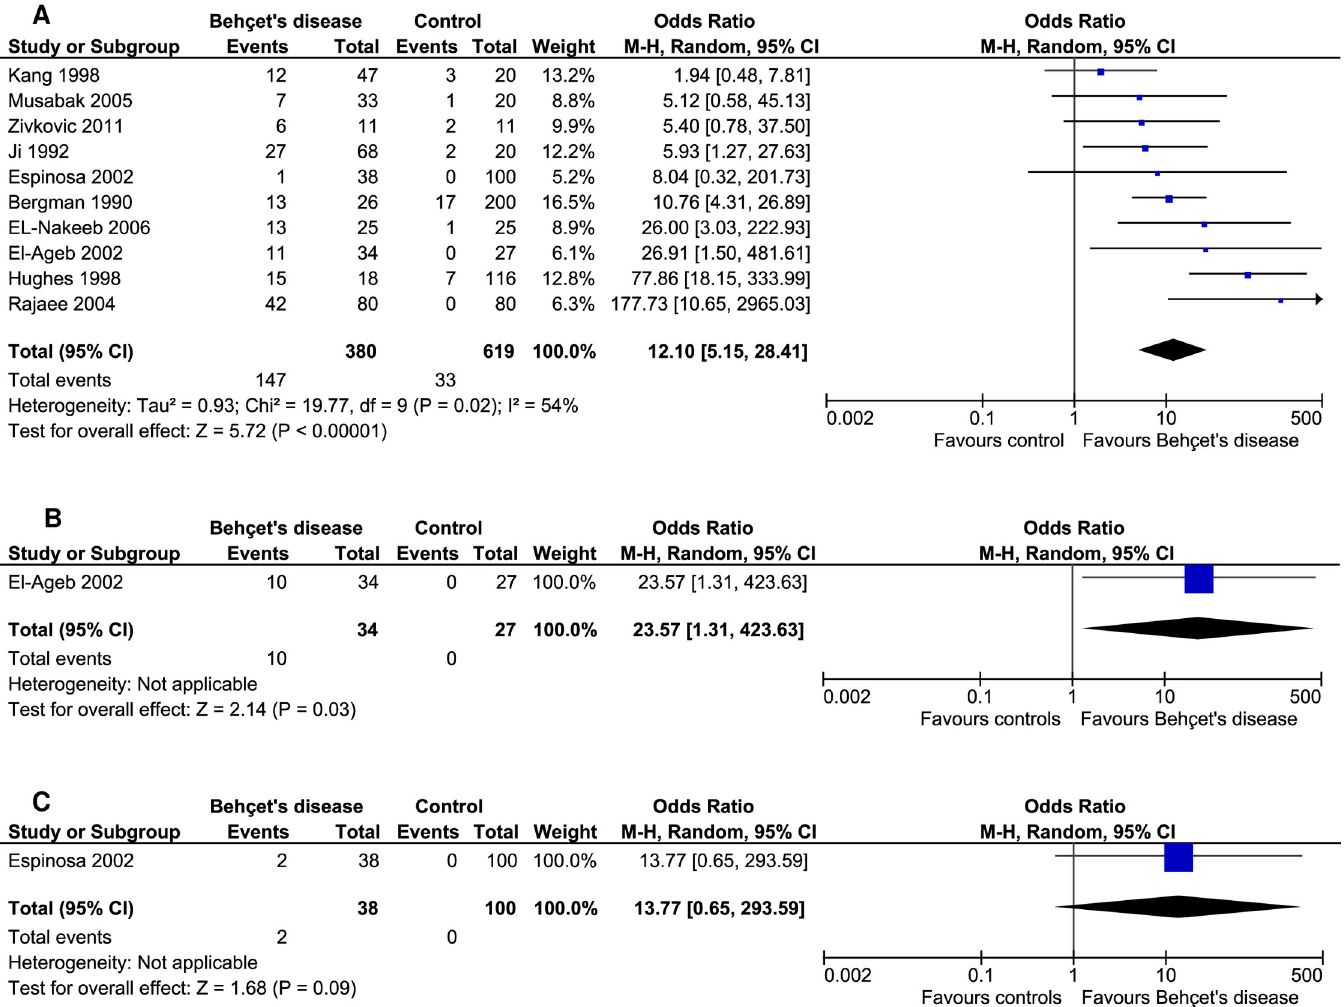
Fig 2. Forest plots showing the prevalence of aCL (A), anti- β 2-GPI (B) and LA (C) in Behc¸et’s disease compared to